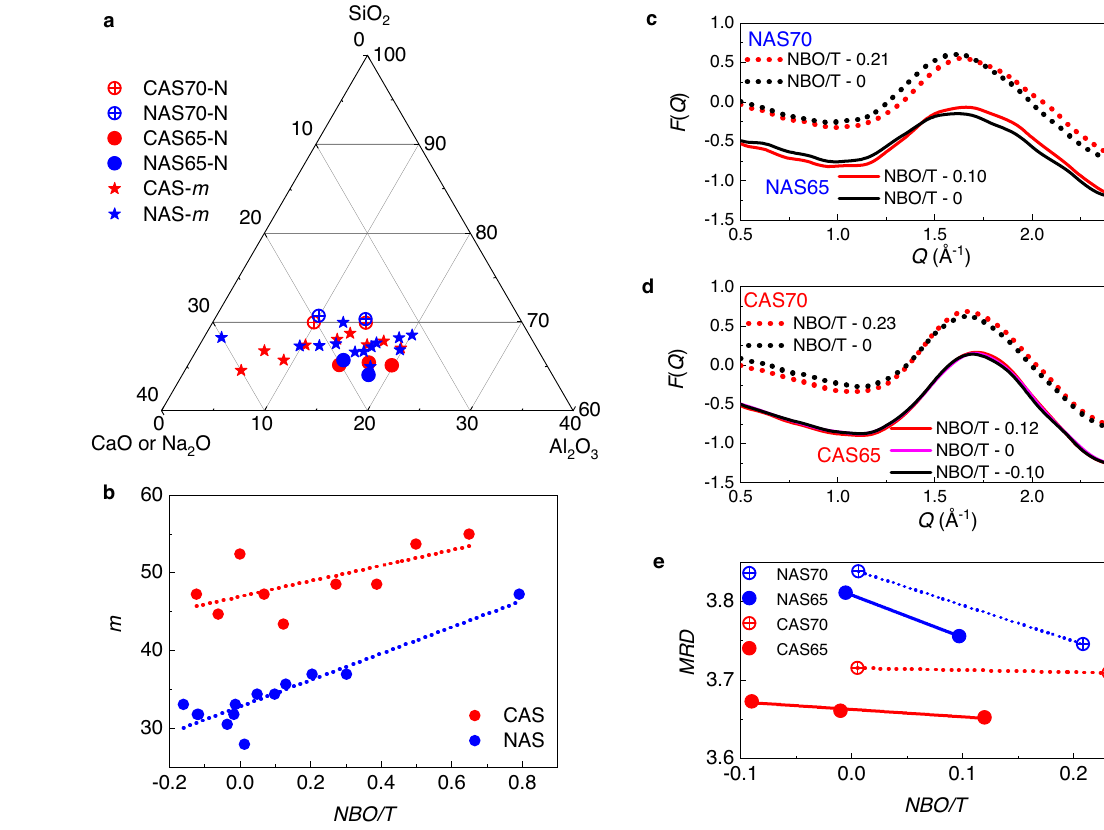
Fig. 4 | Inverse correlation of m - MRD for Group III ’ s 13-NAS and 9-CAS glasses. a Compositions of CAS (red) and NAS (blue) glasses, with m measured by a DSC method 24 (solid symbols) and MRD measured by neutron total-scattering (crossed symbols), as shown in the ternary phase diagram in mol%. b Fragility index ( m ) is plotted as a function of NBO/T ratio for CAS (red) and NAS (blue) glasses. Room- temperature F ( Q )-FSDPs of glasses for CAS ( c ) and NAS ( d ) with compositions close